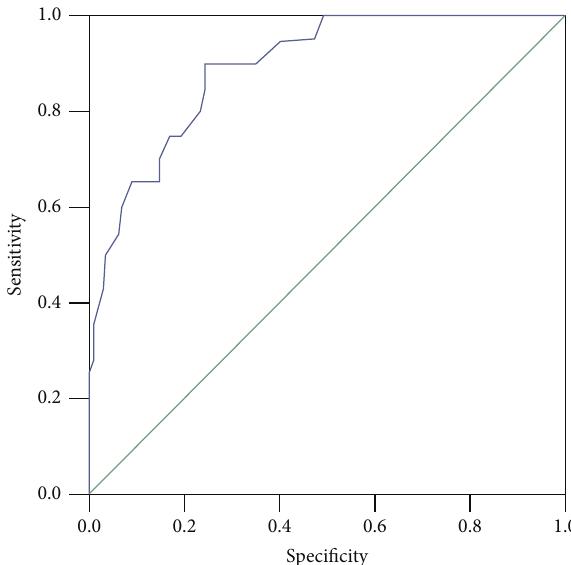
Figure 1: ROC curve showing the predictive probabilities of serum PEDF for type 2 diabetes mellitus. The number of GDM patients included to the ROC analysis was 110 (10 subjects were lost to